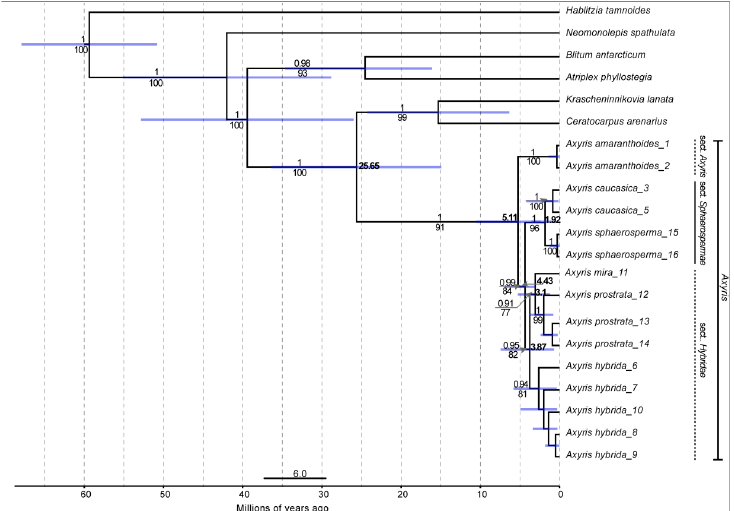
Figure 6. The maximum clade credibility tree of Axyris obtained by the BEAST2 analysis was subjected to secondary calibrations (see Methods). Posterior probabilities resulting from the Bayesian analysis are indicated above branches (only values ≥ 0.9), and the numbers below branches refer to bootstrap values resulting from the ML analysis (only values ≥ 70). Mean divergence times (values at some nodes) are shown with their 95% HPD (blue bars).